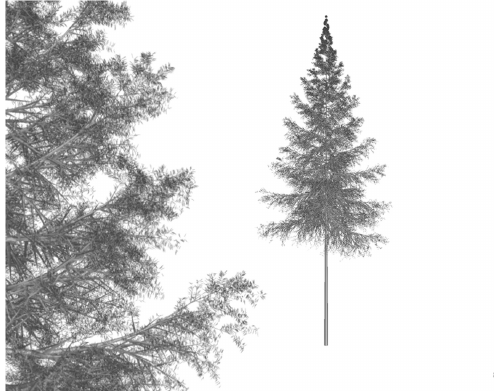
Figure 1. An illustration of the level of detail in Arbaro tree modelling software.